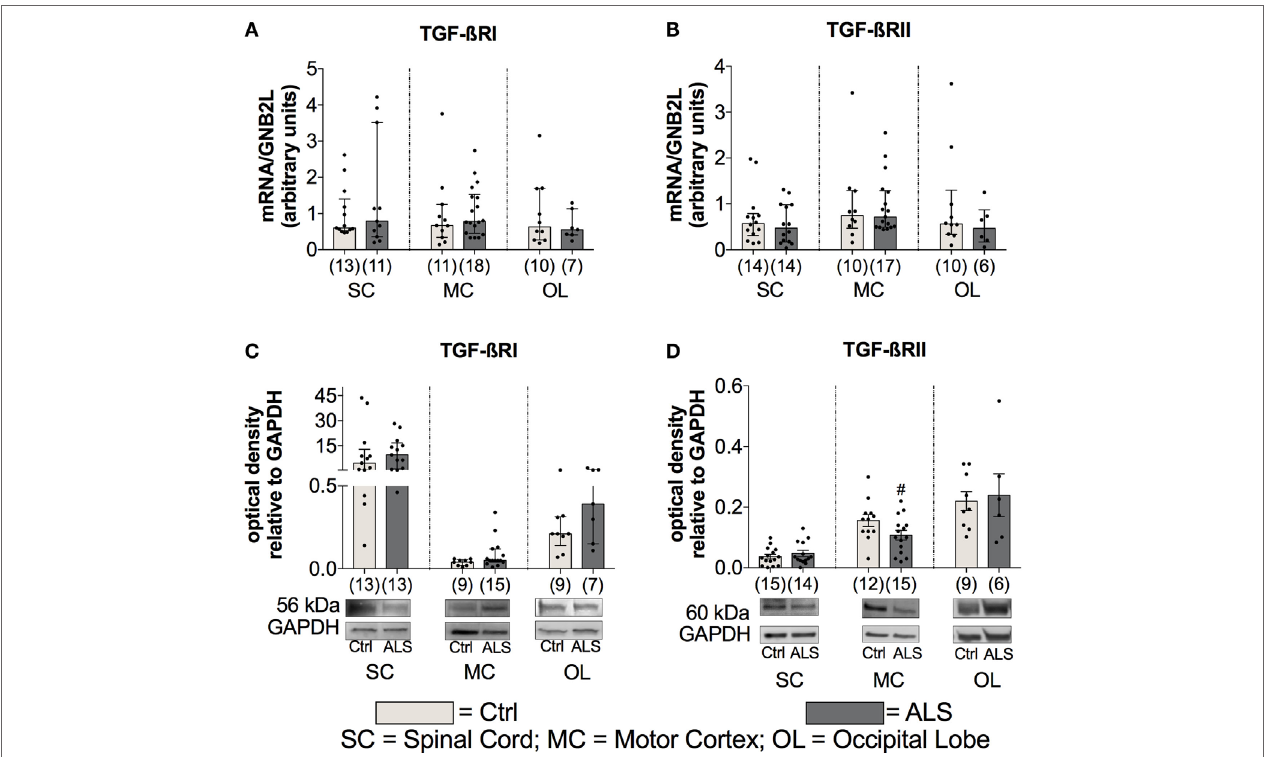
FigUre 6 | Tissue concentrations of TGF­ β receptors. For the TGF­ β receptors, there was no difference in the mRNA expression levels of the TGF­ β RI (a) and the TGF­ β RII (b) . For protein expression, there was no alteration for the the TGF­ β RI (c) and only a trend toward a reduced protein expression of the TGF­ β RII and only in motor cortex (MC; D ) of Amyotrophic lateral sclerosis (ALS) patients compared to healthy controls (Ctrl). # = trend, p = 0.062. Numbers of patients are given in brackets; all parameters were tested for Gaussian distribution using D’Augostino­Pearson omnibus normality test. Two­tailed Mann–Whitney test for TGF­ β RI, TGF­ β RII mRNA expression levels and TGF­ β RI protein expression levels, data represent median with interquartile range, two­tailed unpaired Student’s t ­test for TGF­RII protein, data represent mean ± SEM. TGF­ β RI and TGF­ β RII protein expression levels were quantified and represented relative to the expression levels of the housekeeping protein